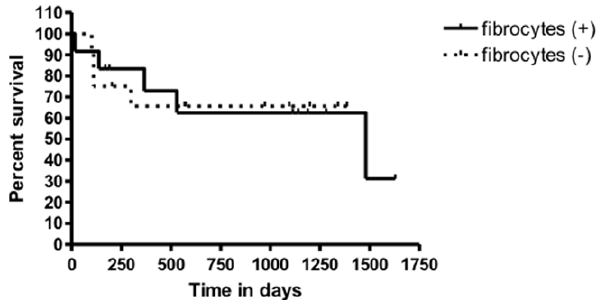
This study demonstrates that fibrocytes are detected in BAL in almost 50% of IPF or SSc-ILD patients whereas these cells are